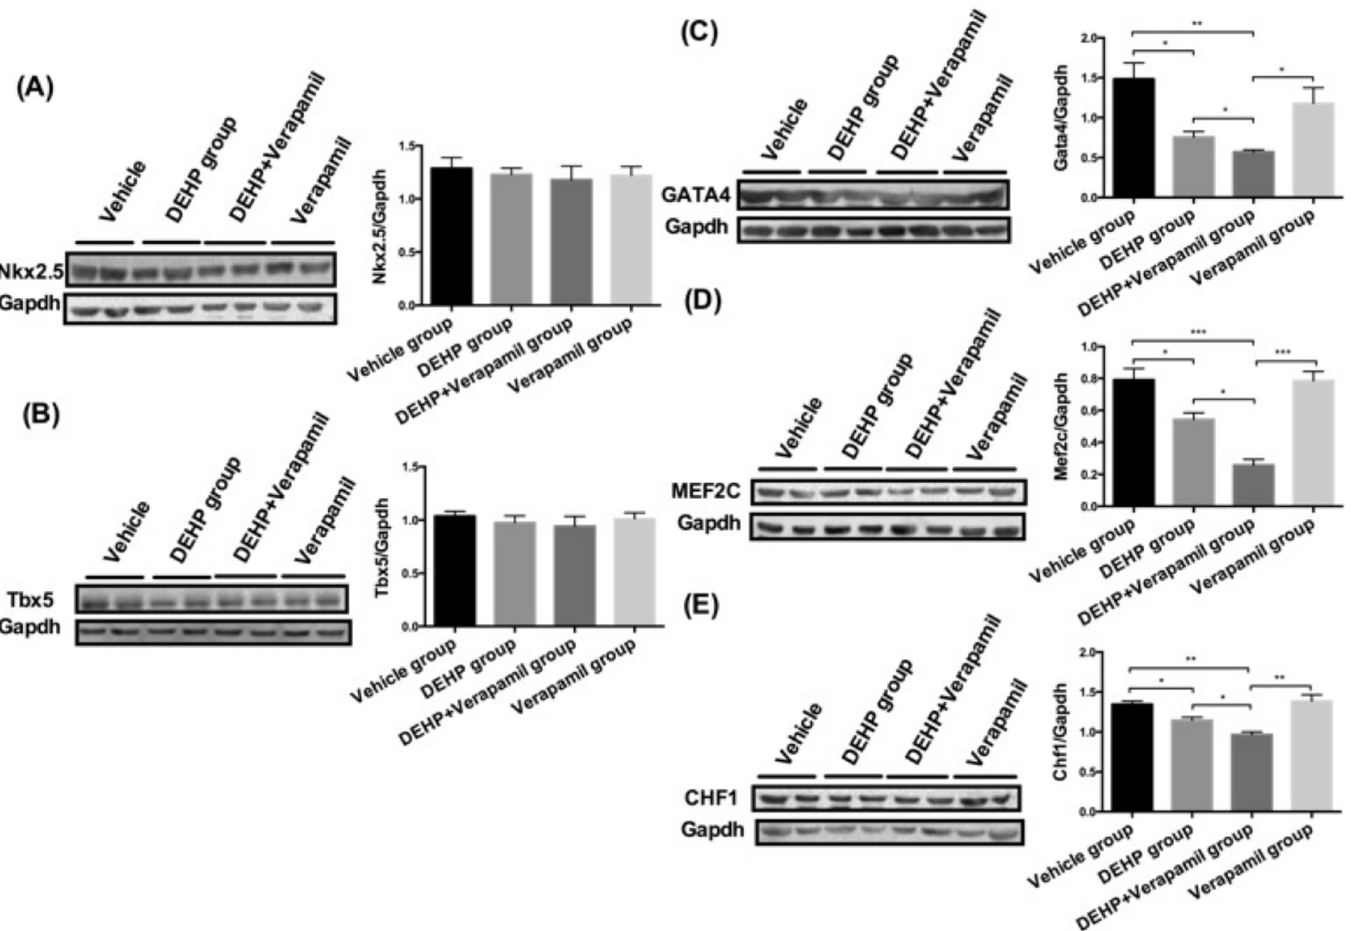
Fig 5. Effect of maternal Di-(2-ethylhexyl)-phthalate (DEHP) and verapamil exposure from E6.5 to E14.5 on fetal heart Nkx2 . 5/Gata4/Tbx5/Mef2c/Chf1 protein expression at E15.5. Differences among different groups were determined by ANOVA followed by a Student–Newman–Keuls multiple comparisons. N = 10, 15, 20 and 10 for vehicle, 500mg/Kg DEHP, 500mg/Kg DEHP & 3mg/Kg verapamil and 3mg/Kg verapamil group, respectively. Data were expressed as Means ± SEM. � P < 0.05, �� P < 0.01, ��� P < 0.001 in comparison with the verapamil group and the vehicle